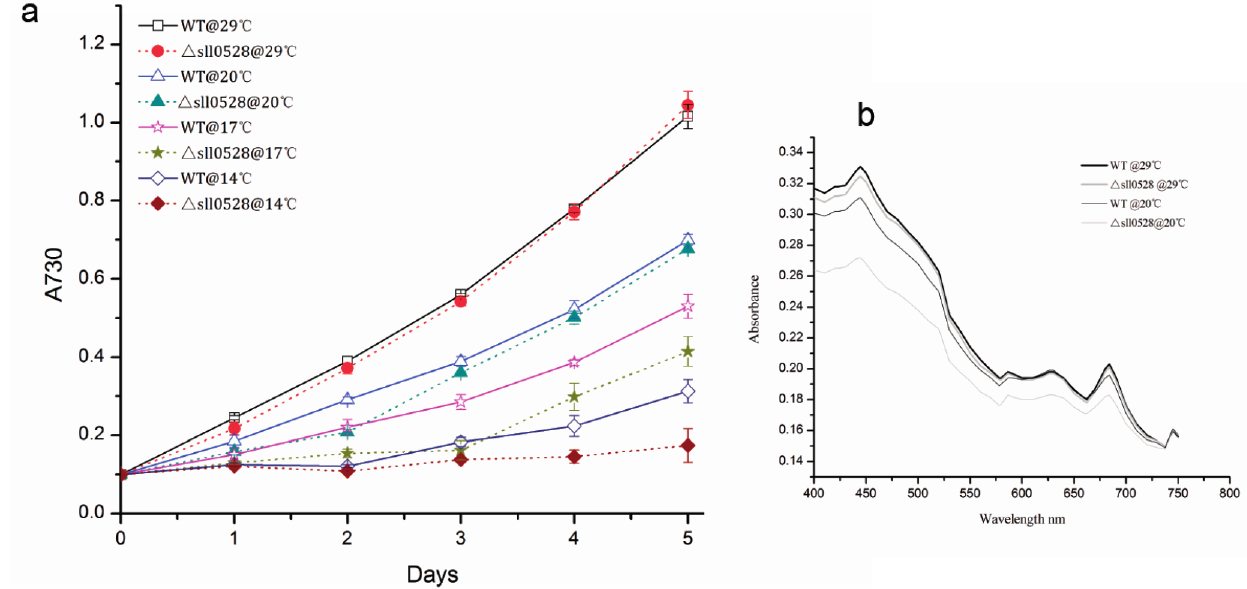
Figure 5. Increased sensitivity of sll0528 mutant to cold stress. ( a ) Growth curve of wild type (WT) and sll0528 mutant ( Δ sll0528 ) at different temperatures. Significant differences were observed between the mutant and wild type at the 2nd day upon 20 °C, from the 2nd to 5th day upon 17 °C and at the 4th and 5th day upon 14 °C respectively ( p < 0.05). Initial OD 730 was 0.1 when the temperature was changed. Each data point represents the mean of at least three independent biological replicates, and the error bars denote SD; ( b ) Absorption spectra of wild type and sll0528 mutant 24 h after transferred to 20 °C, normalized to OD 730